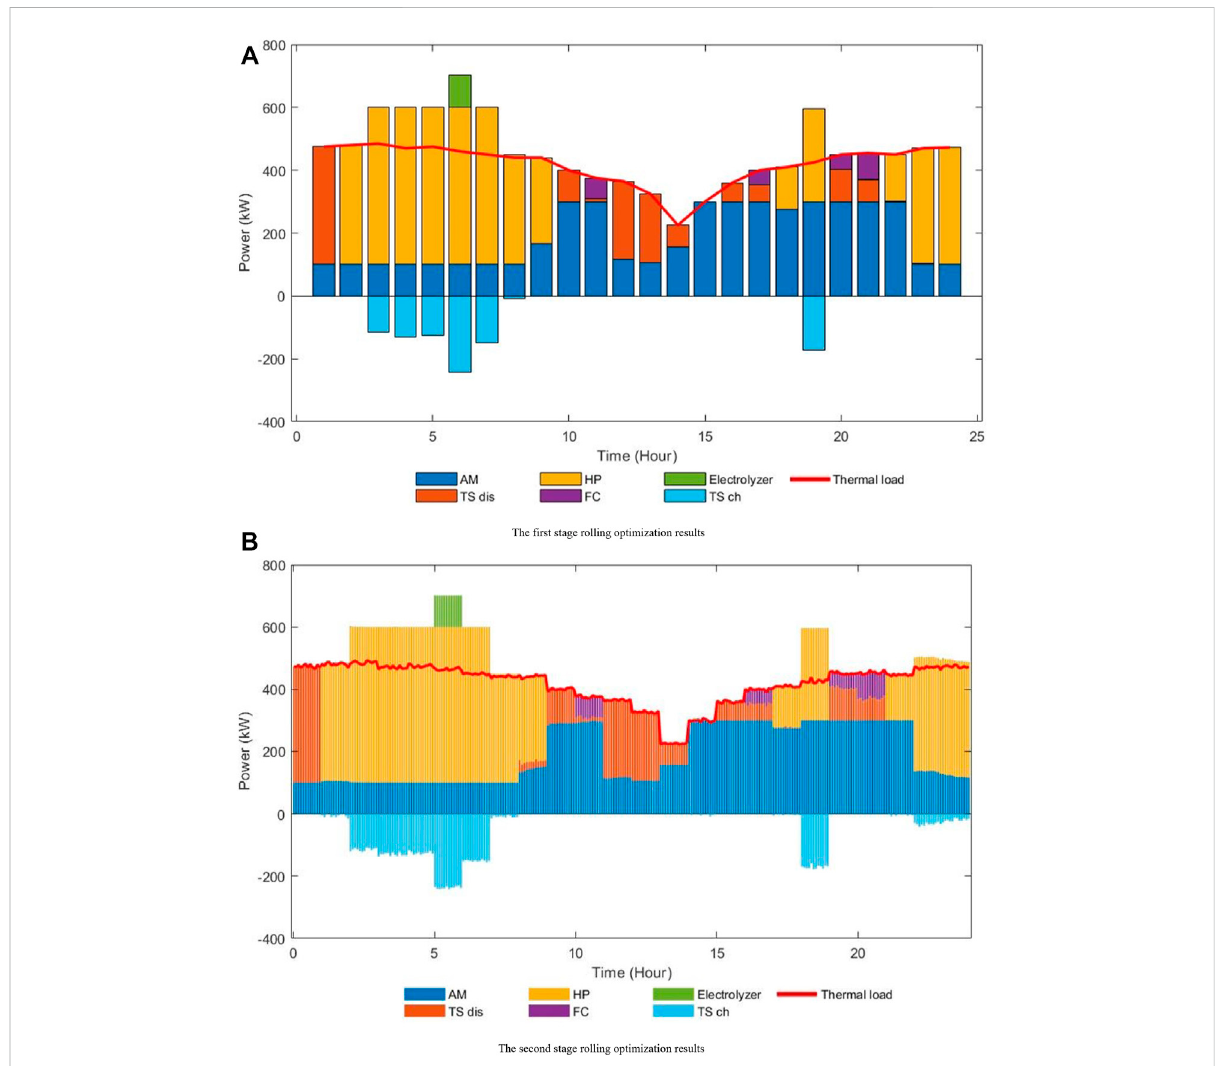
FIGURE 6 WinterthermaloptimizationresultsofMPCrollingoptimizationlayer. (A) The fi rststagerollingoptimizationresults. (B) Thesecondstagerolling optimization